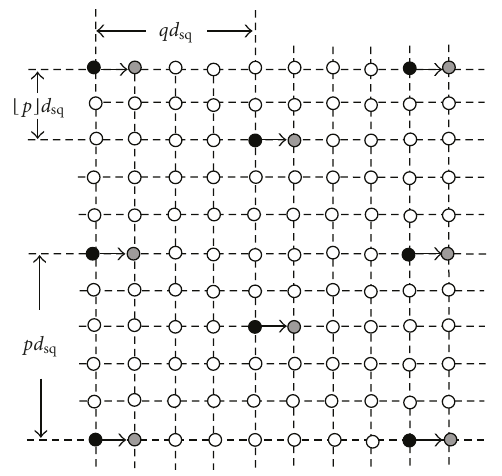
Figure 1: A network on the square grid with the spacing d sq me- ters between two adjacent nodes. Under the SAM, data packets are transmitted from the black nodes to their neighboring gray nodes during a time slot. The vertical spacing between two active transceivers is pd sq meters, and the horizontal spacing between two active transceivers is qd sq meters. The o ff set between two adjacent columns of active transceivers is (cid:2) p/ 2 (cid:3) d sq